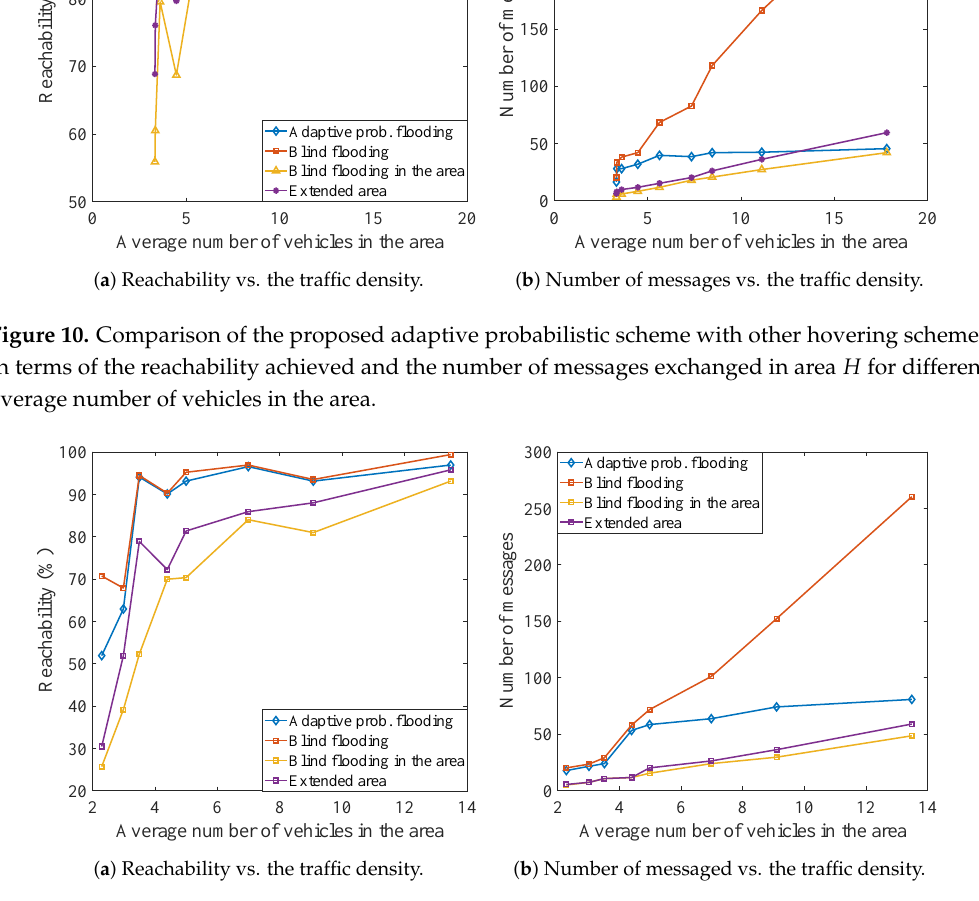
Figure 11. Comparison of the proposed adaptive probabilistic scheme with other hovering schemes in terms of the reachability achieved and the number of messages exchanged in area G for different average number of vehicles in the